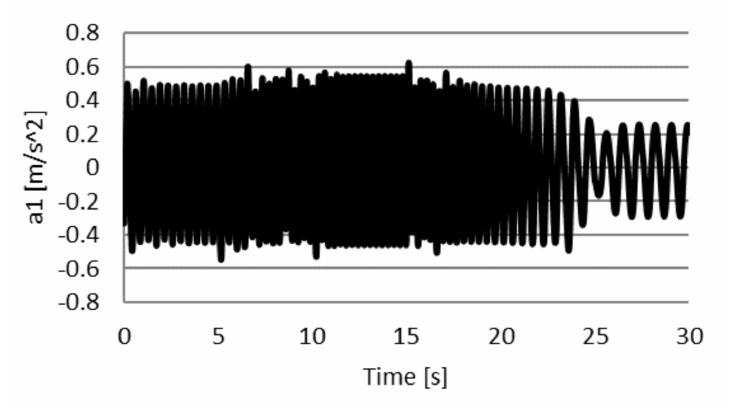
Figure 14. The change in vertical accelerations over the front axle without control.